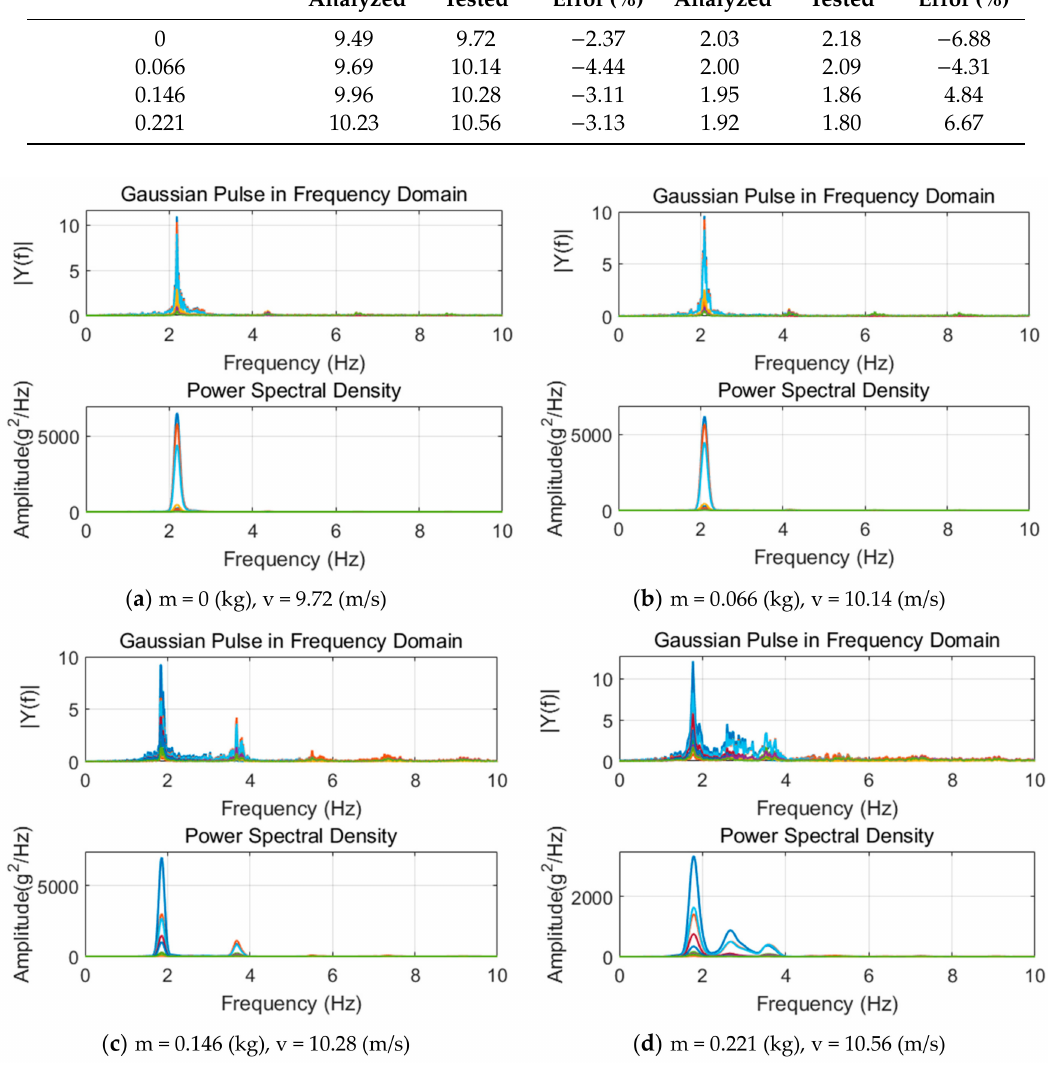
Figure 18. Time-domain acceleration signal and frequency spectrum at di ff erent